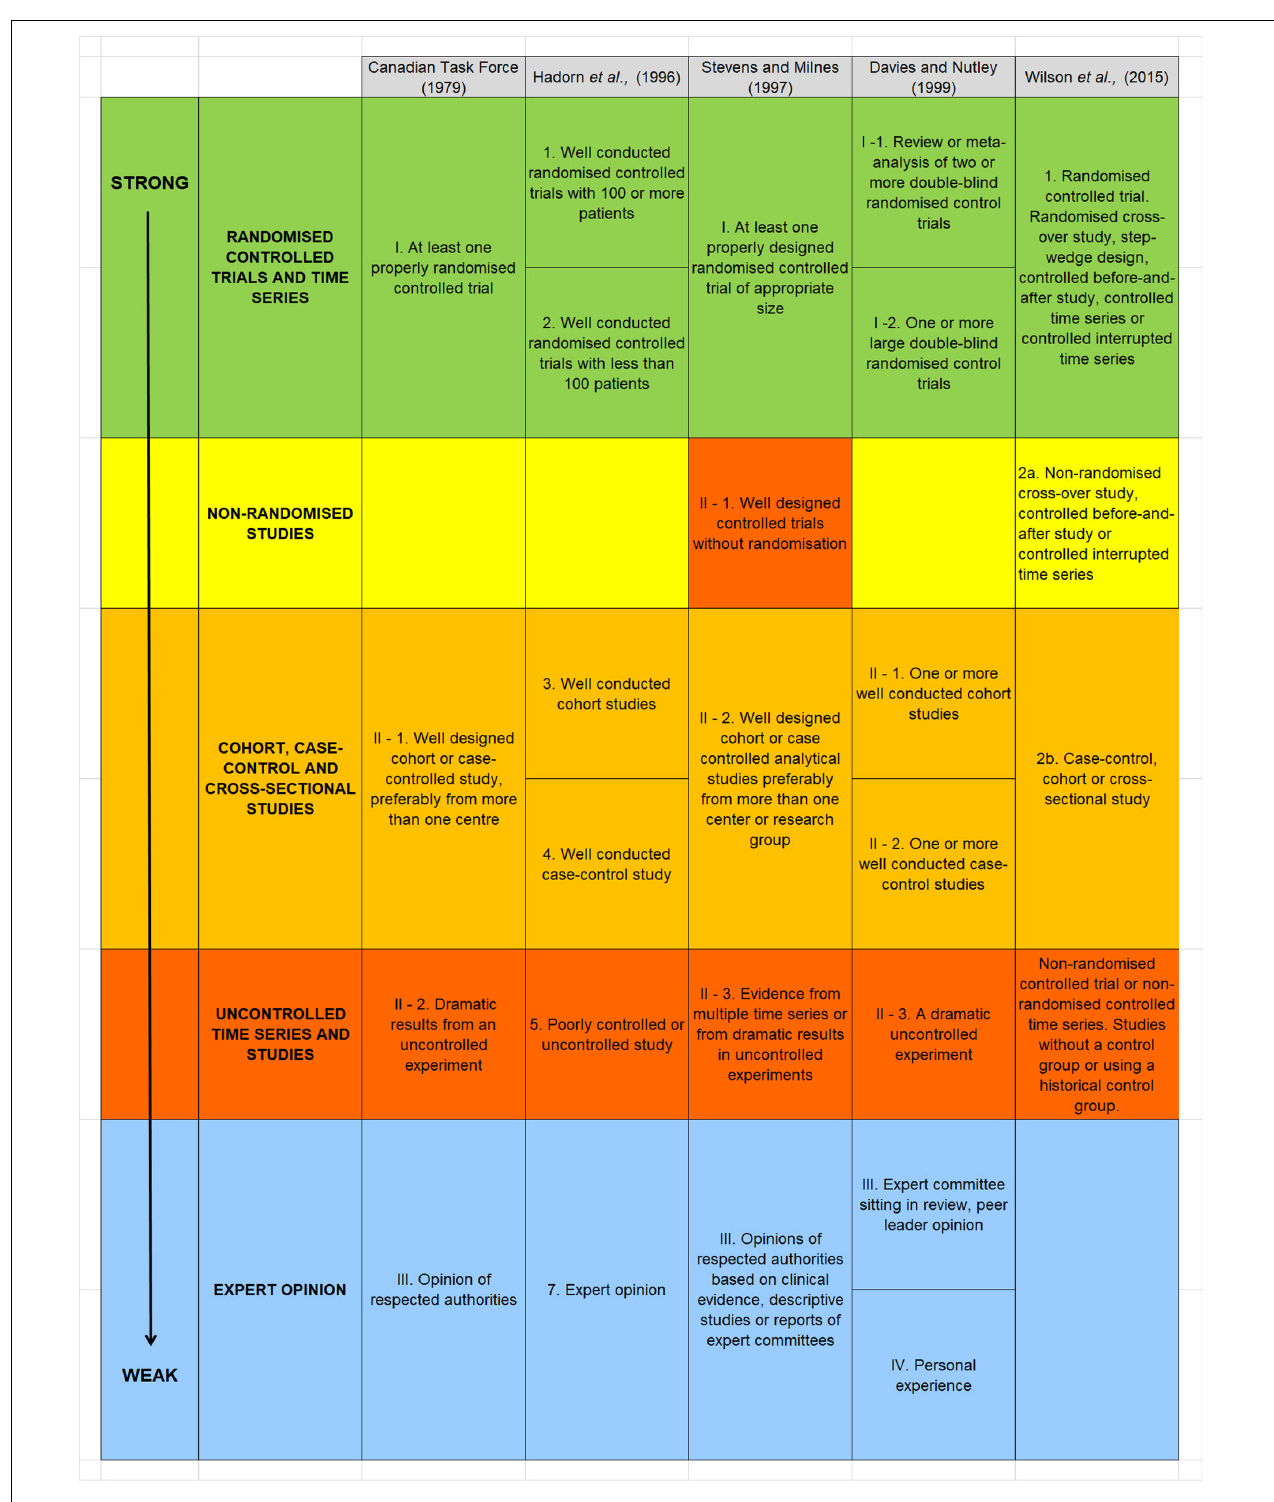
FIGURE 1 | Summary of five hierarchies of evidence drawn from the medical, health care and epidemiological literature. Text and enumeration are taken from the original references. Stevens and Milne (1997) is reproduced from Pullin and Knight (2001). With the exception of non-randomized controlled trials, the structure of each of the five hierarchies is remarkably equivalent allowing studies to be allocated to one of five broadly equivalent groups, ranked from highest (top) to weakest (bottom) . We have added a color scheme to help emphasize this similarity and also identify one outlier: Stevens and Milne (1997) rank well designed controlled trials without randomization relatively high, whereas Wilson et al. (2015) rank this type of study design as providing a much weaker type of evidence.